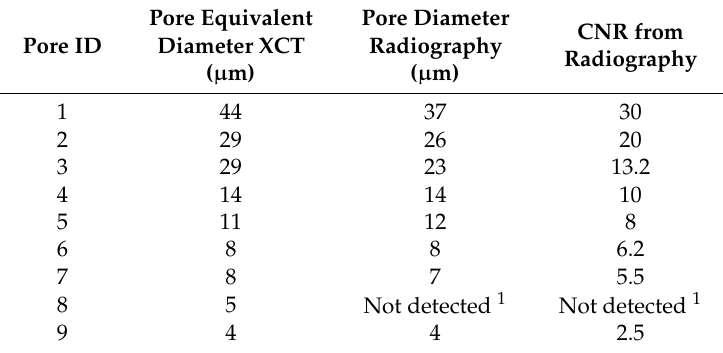
Figure 10. A rendered tomographic image and one radiographic projection of the single-particle sample with nine pores are shown in ( a ) and ( b ), respectively. In ( a ), the pores are numbered in correspondence to the index of the pores in Table 3. The contrast and brightness of ( b ) were enhanced based on filtering and a histogram correction, as presented in ( c , d ). In image ( b ), two red lines mark the profiles which belong to big pore no. 1 ( e ) and small pore no. 9 ( f ), respectively. Small pore no. 9 is highlighted by an arrow in ( d , f ). Table 3. Measured CNR of pores in the single-particle